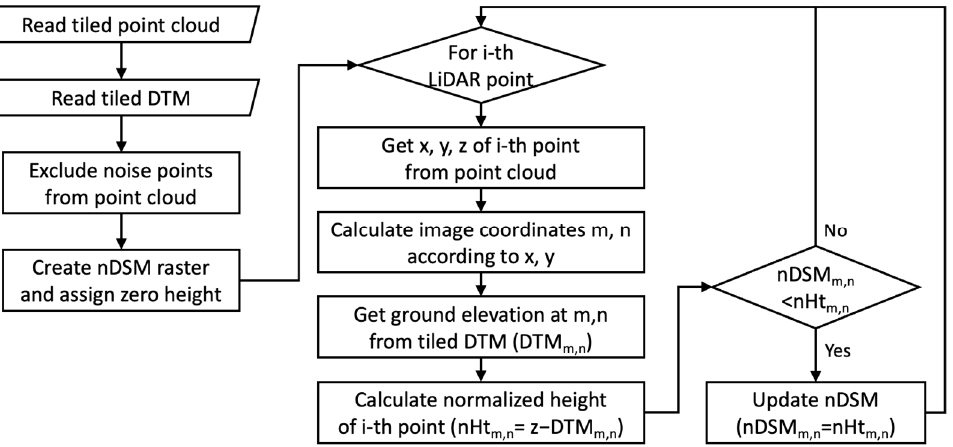
Figure 4. A workflow to generate the tiled normalized digital surface model (nDSM) using 3D Elevation Program (3DEP) LiDAR and digital terrain model (DTM) data. nHt: normalized height. Tiled nDSM data were combined to generate a countywide CHM (Figure 5). All